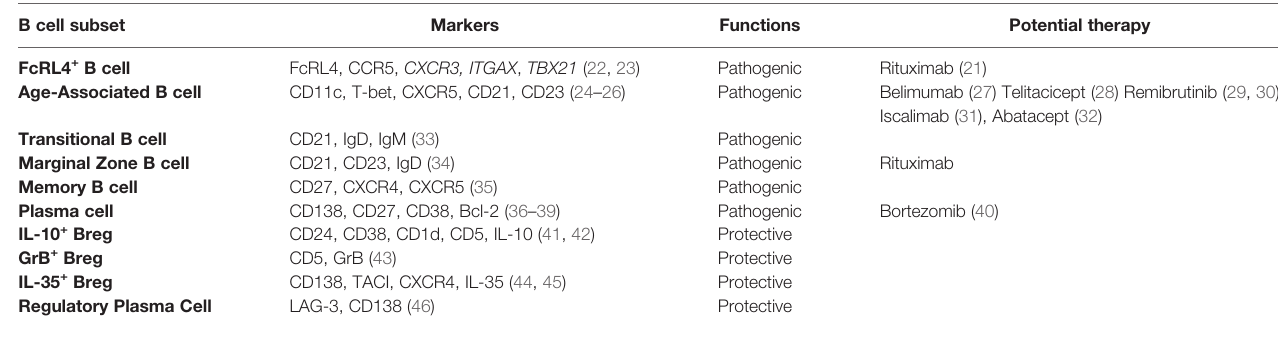
TABLE 1 | Pathogenic and regulatory B cell subsets in pSS. B cell